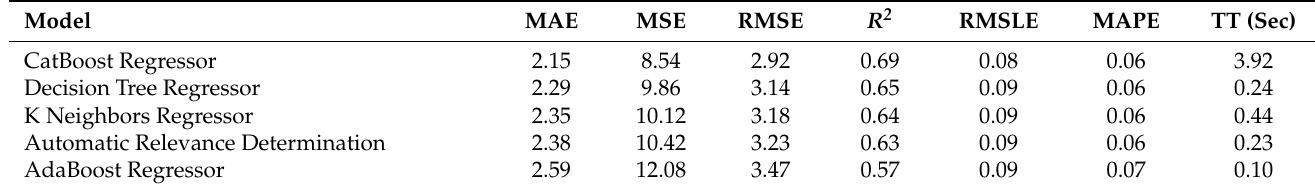
Table 3. Performance metrics of the models composed of the algorithms in default mode.